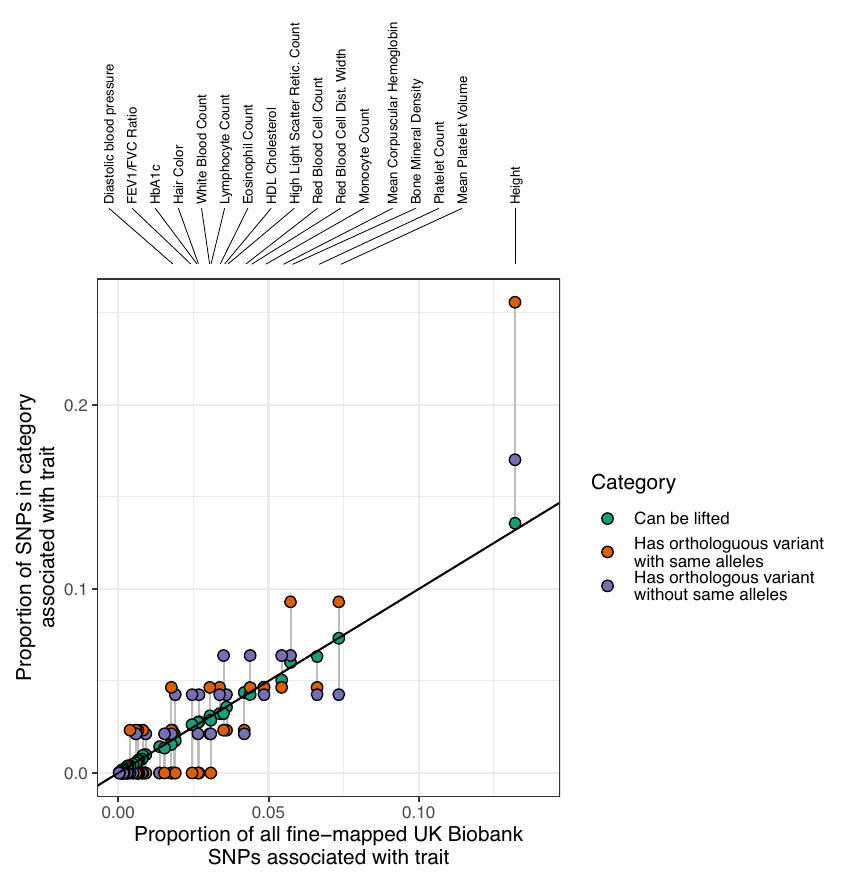
Fig. 5 Orthologues of fi ne-mapped variants linked to traits in the UK Biobank. All 2240 fi ne-mapped UK biobank variants were lifted over to the cattle genome and the number that overlapped a variant in the cattle genome with and without the same alleles were determined. The Y-axis shows the proportion of all SNPs that could be lifted that are associated with each trait (green), that have an orthologue with the same alleles (orange) or that have an orthologue with different alleles (blue). These values are compared to the expected values (X-axis) as represented by the proportion of all fi ne-mapped variants linked to the given trait. Circles corresponding to the same trait are connected by vertical grey segments, with the trait indicated above for those traits with at least 55 fi ne-mapped variants. The proportion of all lifted variants that were associated with a given trait is strongly correlated with the original proportion of fi ne-mapped variants linked to that trait (green circles). However, variants with an orthologous cow variant are disproportionately associated with height, and in particular those with matching alleles in both species (orange circles). The data underlying this fi gure can be found in Supplementary Data